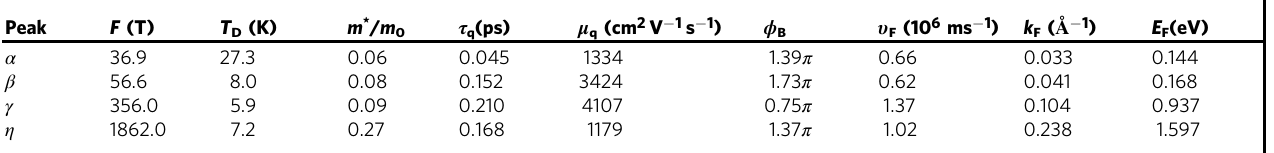
Table 1 Parameters extracted from dHvA